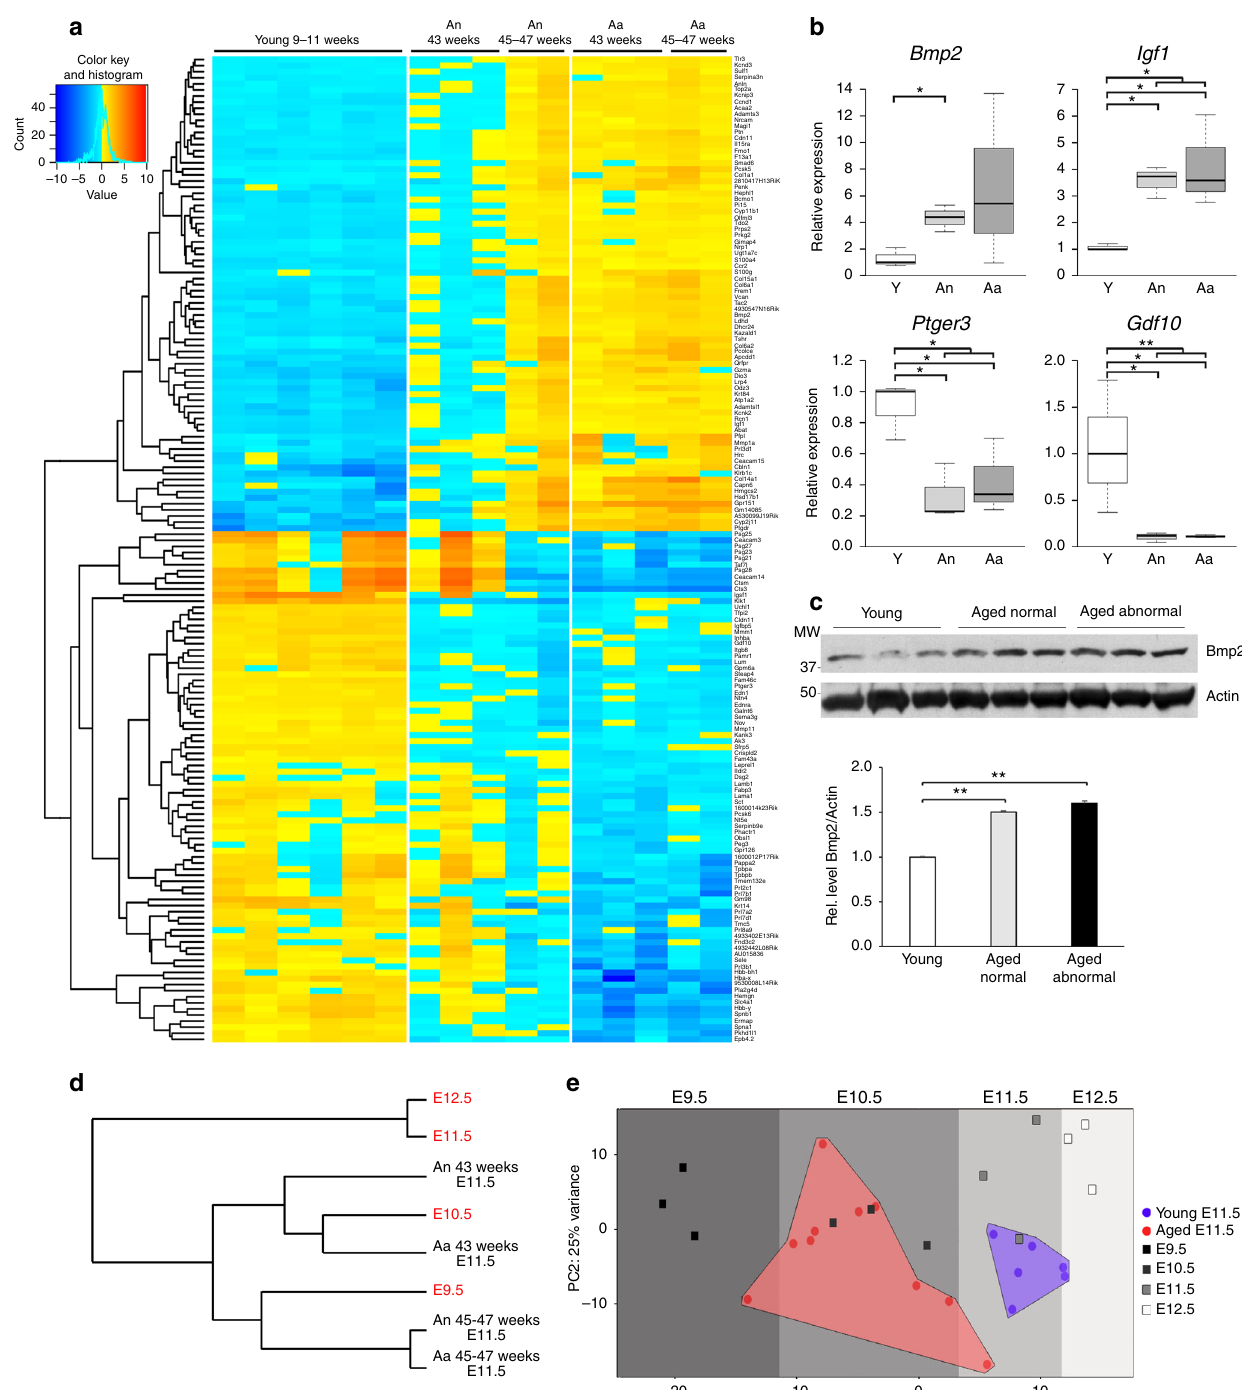
Fig. 3 Decidual compartment is abnormal and exhibits hallmarks of developmental delay in conceptuses developed in aged females. a Heatmap of genes commonly de-regulated in the decidual portion of placentas developed in aged females compared to young controls. Please note that the extent of gene de-regulation increases with age of the female (43 vs. 45 – 47 weeks of age) and is also more pronounced in deciduas associated with abnormal embryos (Aa). Genes selected for display were signi fi cantly different between young (Y) and Aa deciduas. b Independent validation of differential gene expression for key decidualisation genes by RT-qPCR. Samples are as in Fig. 1c. Data are displayed as mean ± S.E.M. * p < 0.05; ** p < 0.01 ( n = 3; ANOVA with Holm-Bonferroni ’ s post-hoc test). c Con fi rmation of higher Bmp2 expression levels in deciduas developed in aged females by Western blot. Quanti fi cation of band intensities of three independent biological replicates is shown in the graph below. ** p < 0.01 (ANOVA with Holm-Bonferroni ’ s post-hoc test). d Closest neighbour analysis of global transcriptomes generated by RNA-seq from E11.5 deciduas from aged females compared to those developed in young females of a developmental time course from E9.5-E12.5 (in red font ). Each line represents transcriptomes of 2 – 9 independent biological replicates (see Supplementary Fig. 4 for all samples), with samples recovered from separate litters in every case. e Principal component analysis of the samples shown in d , showing that the E11.5 deciduas recovered from aged females exhibit an expression signature more closely resembling that of E9.5 – 10.5 young